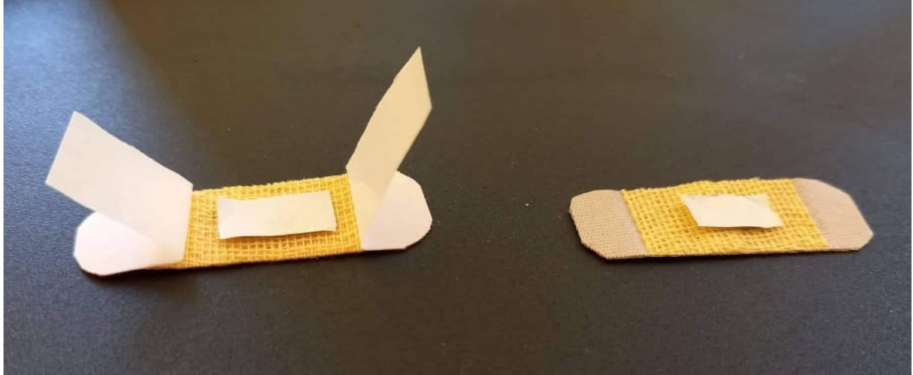
Figure 1. Illustration of preparing nanofiber samples prior to being applied to the animal group. Randomly, 9 batches of 5 mice each received the nanofiber test